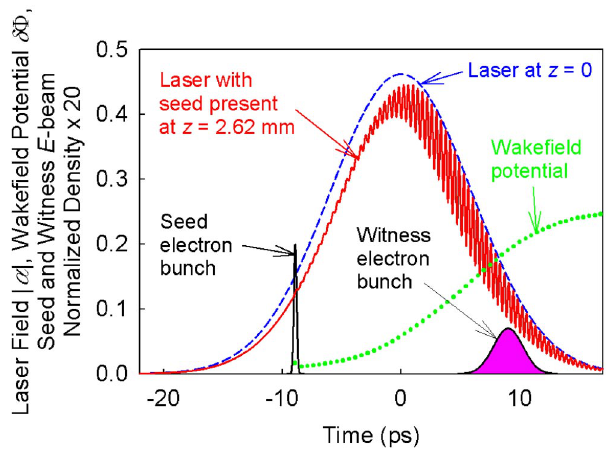
FIG. 6. (Color) Model prediction for laser field parameter j a (cid:5) r (cid:1) 0 (cid:6)j and wakefield potential (cid:7) (cid:1) (cid:5) r (cid:1) 0 (cid:6) as a function of (cid:1) 8 : 91 ps . Also plotted are the seed and witness time for t d (cid:1) 17 ps and j a (cid:5) r (cid:1) 0 ; z (cid:1) 0 (cid:6)j e -beam bunch positions for (cid:1) d